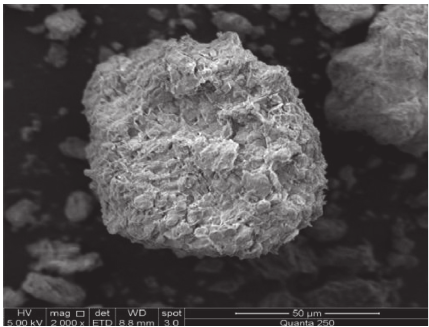
Figure 4: SEM image of the ZnO/sepiolite composite prepared by the hydrothermal reduction method.